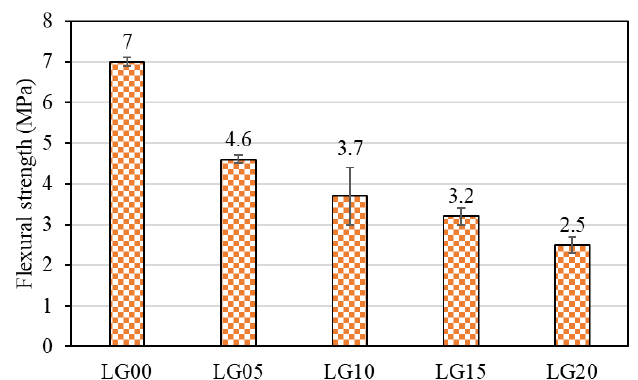
Figure 7. Compressive strength of geopolymer mortar containing BLWA.